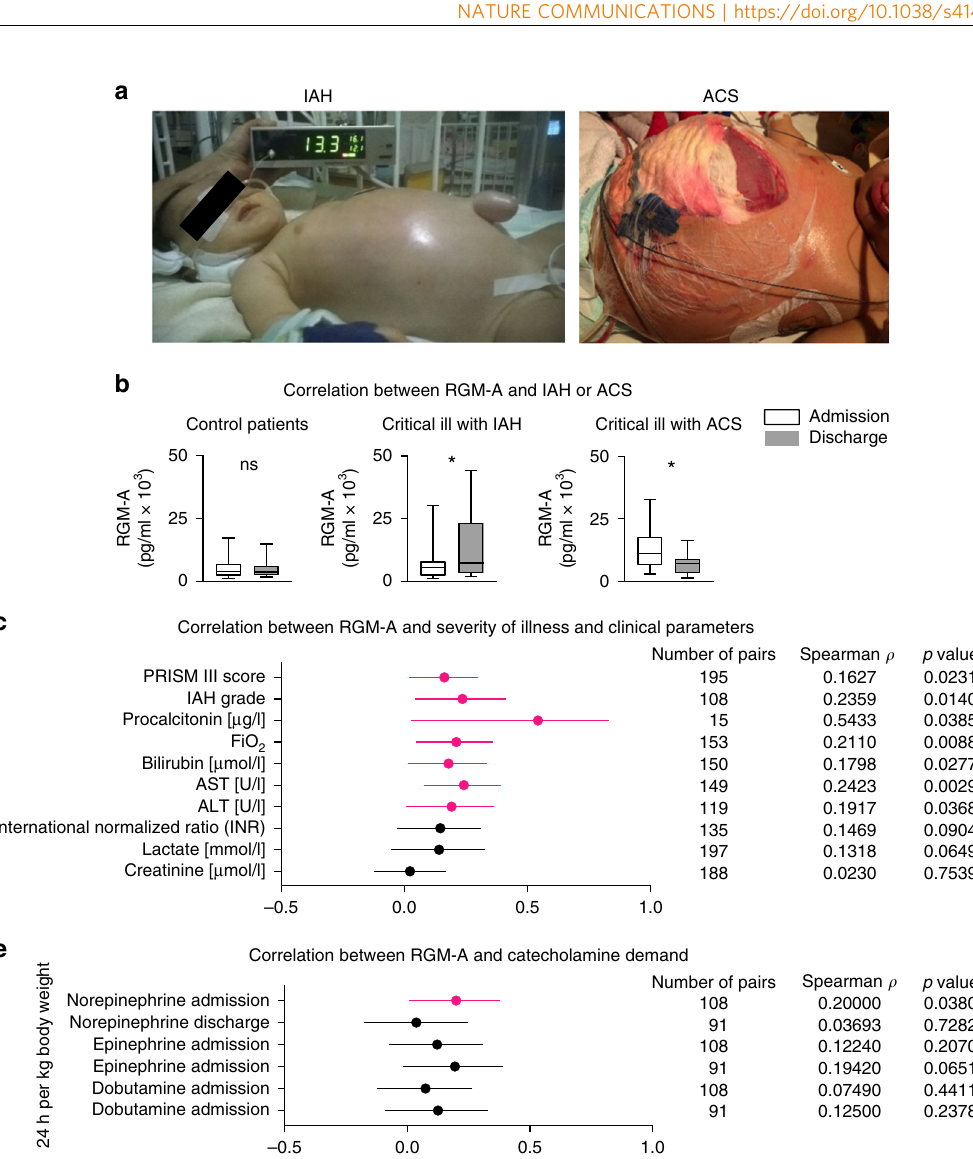
Transcriptional analysis . The transcriptional analysis of human RGM-A mRNA expression was performed using the sense primer 5 ′ -AAC CAG CAG ATC GAC TTC CAG-3 ′ and antisense primer 5 ′ -ACG GCT GTC TCG TAT GGG A-3 ′ . Human 18S expression was evaluated with the sense primer 5 ′ -GTA ACC CGT